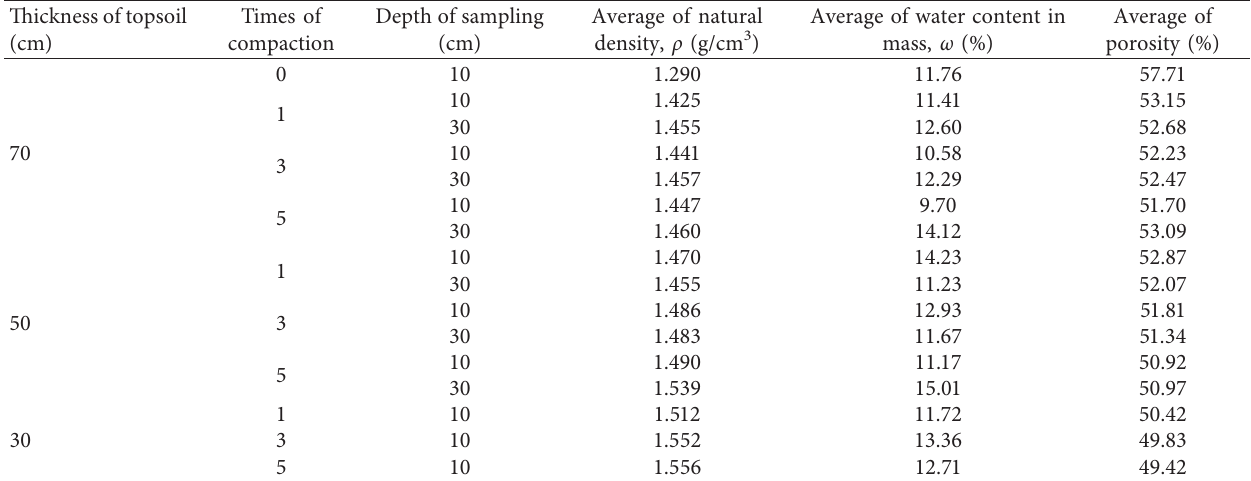
Figure 8: Technology roadmap. Table 1: Results of the compaction experiment.